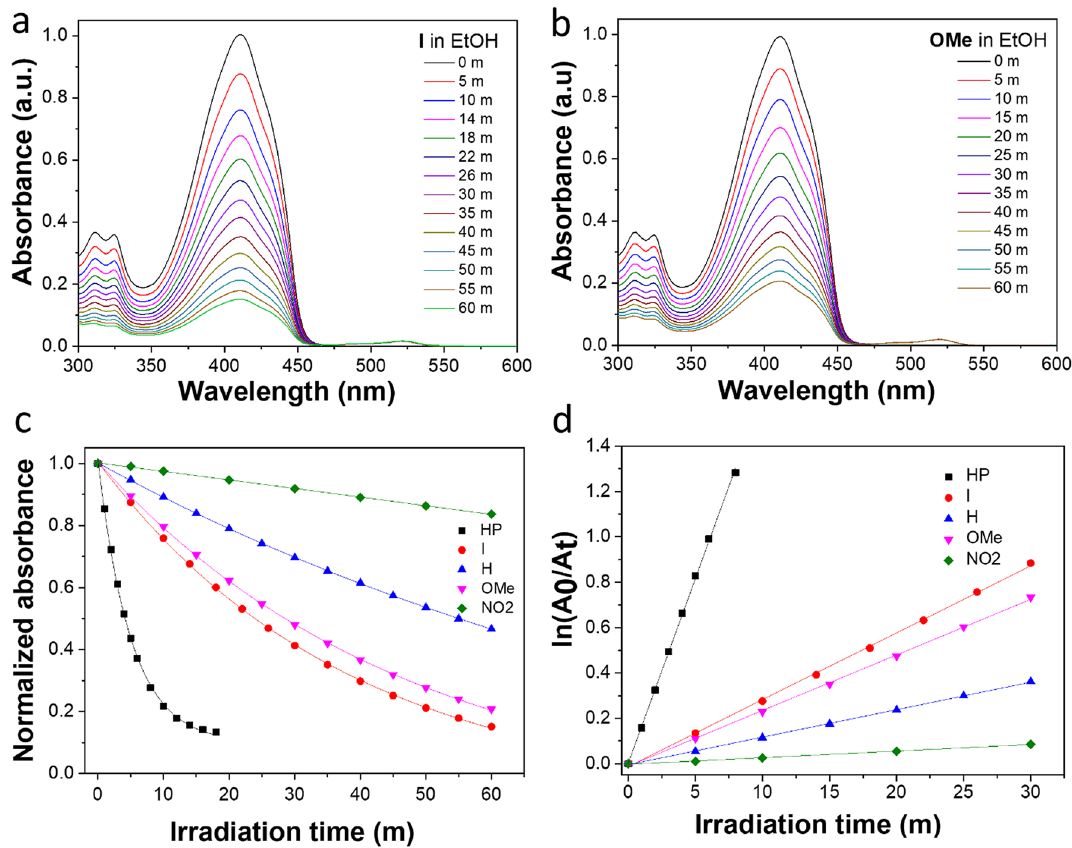
Figure 3. The singlet oxygen ( 1 O 2 ) generation capabilities of BODIPY PSs. Absorption spectra of DPBF upon irradiation in the presence of ( a ) I and ( b ) OMe under 520 nm for different times. ( c ) Plots of the change in absorbance of DPBF at 414 nm at different irradiation times using hematoporphyrin (HP) as the standard in EtOH at room temperature ( Φ Δ = 0.53). ( d ) 1 O 2 assay using the absorbance attenuation of DPBF in the presence of BODIPY I , H , OMe , and NO2 against HP as the standard in